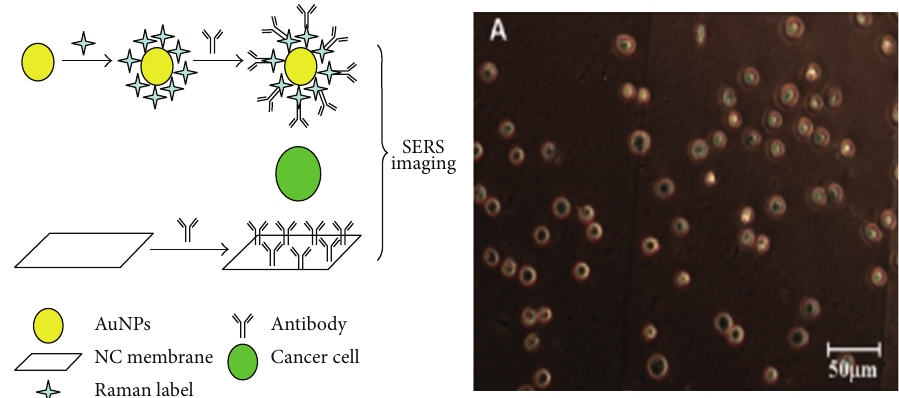
Figure 9: Detection of circulating tumor cells on NC membranes containing immobilized cAbs (adapted from [35]).